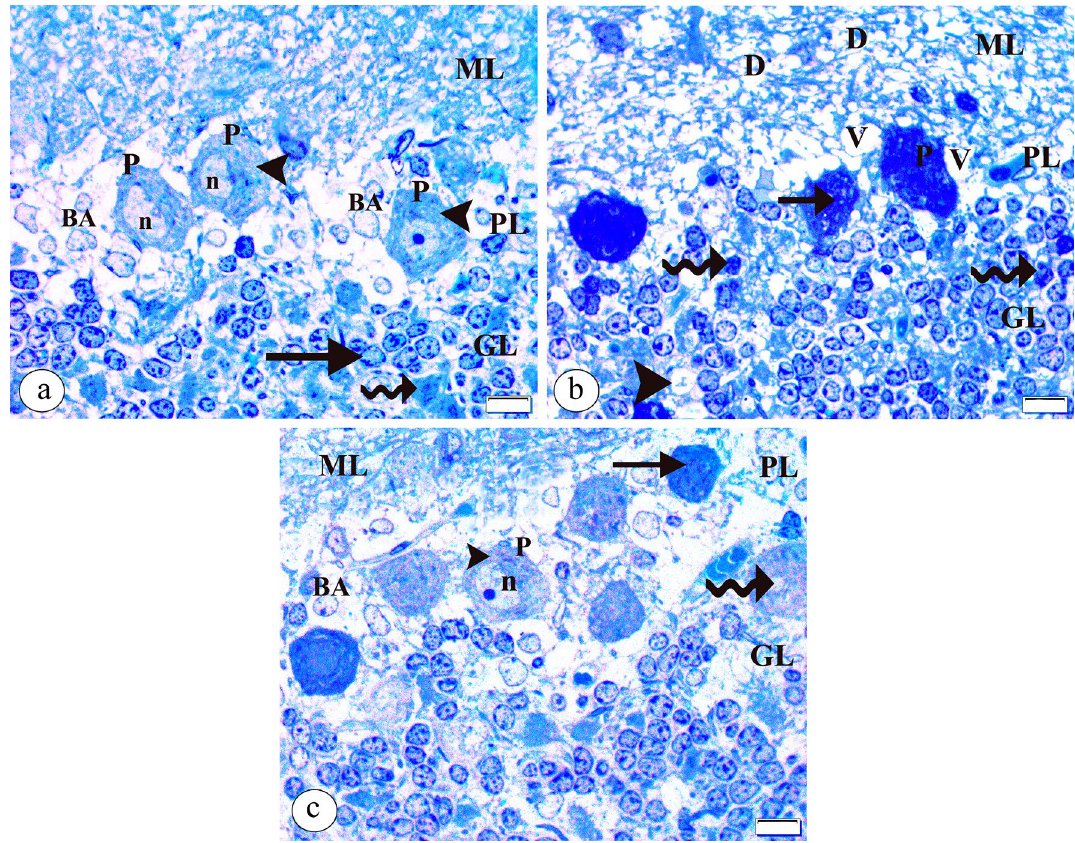
Figure 2. A photomicrograph of the semithin sections of the cerebellar cortex in ( a ) the control group showing the molecular layer (ML), Purkinje cell layer (PL), and granular cell layer (GL). The normal appeared Purkinje cell (P) with central vesicular infolded nucleus (n) and homogenous cytoplasm (arrowhead) encircled by Bergmann protoplasmic astrocytes (BA) with granular chromatin. The granule cells (arrow) have darkly stained nuclei with granular chromatin and the cerebellar islands (curved arrow) are noticed in between. ( b ) the tartrazine-treated group showing degenerated areas (D) in the molecular layer (ML). The Purkinje cell layer (PL) shows dark Purkinje cells (P) with an irregular outline and an invisible nucleus. Shrunken Purkinje cell (arrow) also appears. The granular cell layer (GL) shows deeply stained cells (curved arrow), vacuolated areas (V), and vacuolated cerebellar island (arrowhead). ( c ) the tartrazine + riboflavin treated group showing the molecular layer (ML) and granular cell layer (GL) appear normal. The Purkinje cell layer (PL) shows normal Purkinje